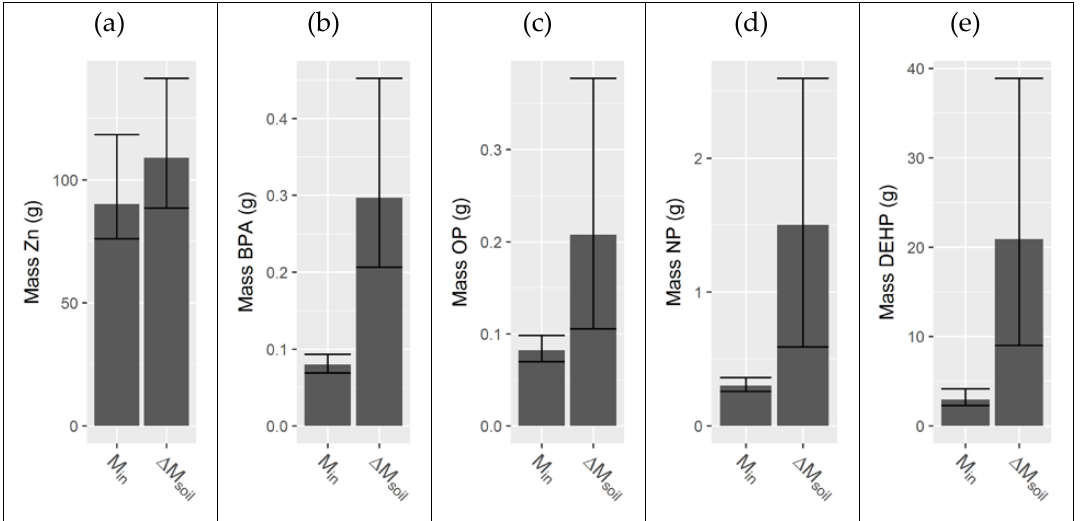
Figure G1. Comparison of inlet mass ( M in ) to the change in soil mass over time ( ΔM soil ) for ( a ) zinc, ( b ) bisphenol-A, ( c ) octylphenol, ( d ) nonylphenol and ( e ) bis(2-ethylhexyl) phthalate. Bars represent medians, while error bars represent the 95% confidence interval.